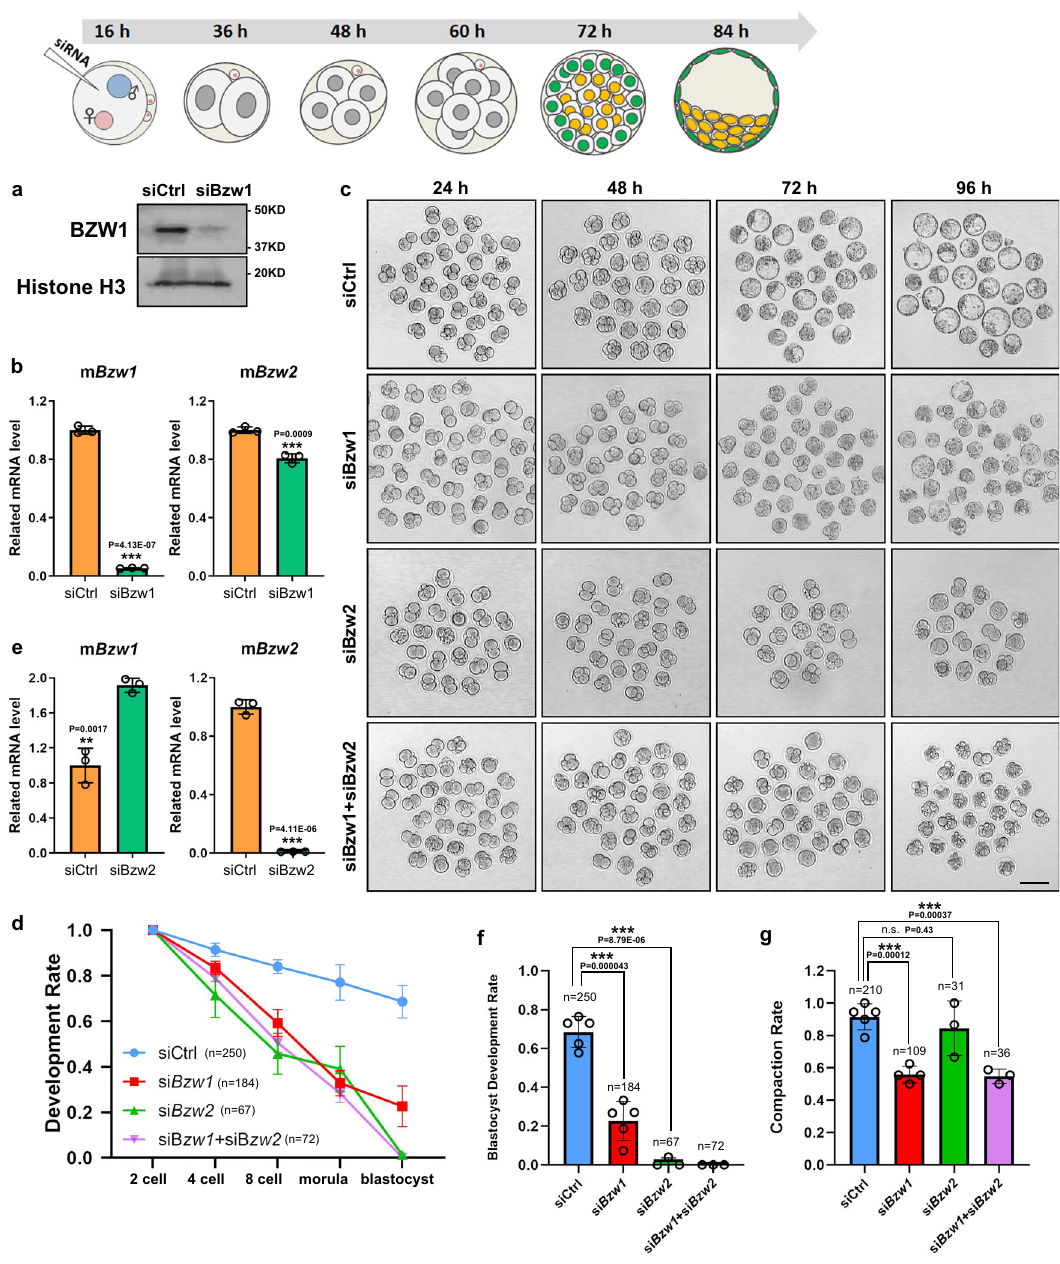
Fig. 2 | BZW1 plays a key role in murine preimplantation embryonic development. a The level of BZW1inembryos obtained by westernblotting atthe 8-cell stage after microinjection of siControl or si Bzw1 in zygotes, which also con- fi rmed the speci fi city of the BZW1 antibody. Histone H3 was used as loading con- trol. Total protein samples from 80 embryos were loaded in each lane. The experiment was repeated two times with similar results. b RT-PCR results showing the mRNA levelsof Bzw1 and Bzw2 inembryo at2-cellstage after microinjection of si Bzw1 in zygotes. Gapdh served as the internal control. n =5 embryos in every sample. The experiment was repeated three times. Data are presented as mean values. The relative mRNA level of Bzw1 in control is de fi ned as 1.0. *** P <0.001, by two-tailed Student ’ s t -tests. Error bars, S.D. c In vivo fertilized eggs were collected from oviducts, microinjected with siControl or the indicated siRNA, and then cul- turedfor3.5daysinvitro.DICimagesoftheembryosthatreachedthe4-cell,8-cell, morula, and blastocyst stages after microinjection. Scale bar, 25 μ m. d The per- centage of embryos microinjected with siControl or indicated siRNA that reached